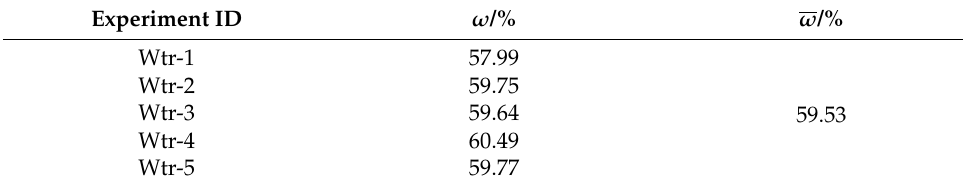
Table 6. Water retention rates of LMP-Bt